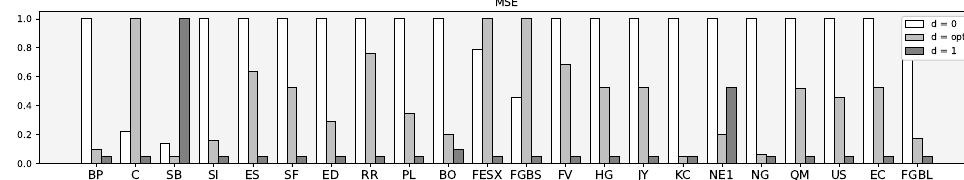
Figure 8. MSE scaled between 0 and